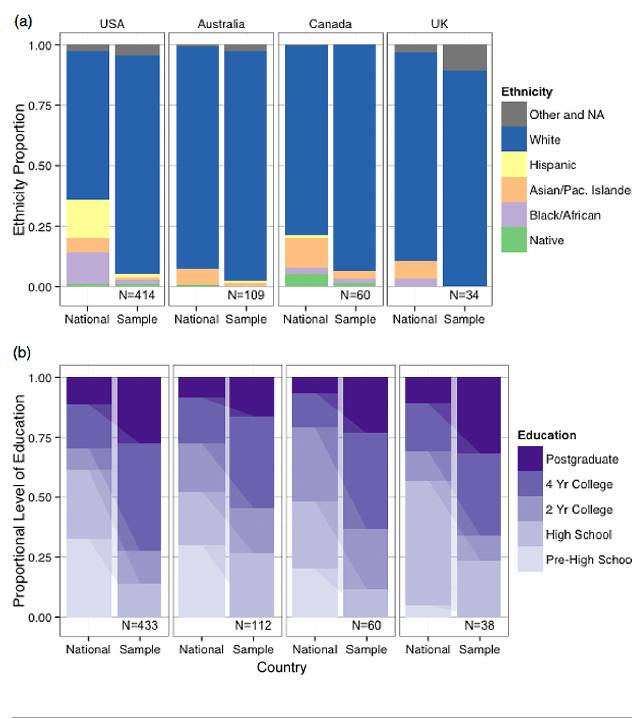
Fig. 2 . (a) Permaculture lacks ethnic diversity. The figure shows a comparative plot of proportional ethnicity, contrasting sample with national distribution for each of the four top-responding countries. In addition to nonresponses, grey blocks here include ethnic categories in national data that do not match with survey categories. In each country the sample is less diverse than the national context. The most diverse of the four countries, the USA, also has the largest number of responses, showing conspicuous underrepresentation in the Hispanic and black/ African categories. (b) Permaculturists have received more schooling than average. The figure shows a comparative plot of level of education, contrasting sample with national distribution for each of the four top-responding countries. Transparent bars connect corresponding levels to aid interpretation. The sample lacks any responses in the lowest level of pre-high school education. Overall, the darker colors in the sample columns show higher levels of education than the national distribution for each